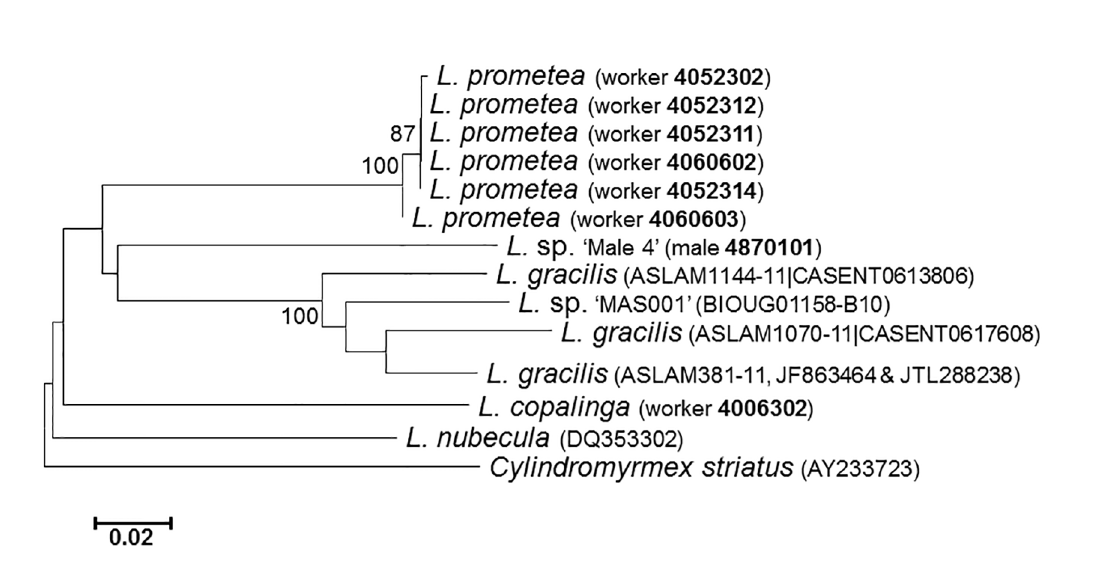
Fig. 11. Neighbour-joining tree showing p-distances among DNA sequences of the mitochondrial COI barcode fragment obtained for all specimens of Leptanilloides Mann, 1823 sequenced here and available in GenBank and BOLD. The tree was rooted with a COI sequence of Cylindromyrmex striatus Mayr, 1870 (GenBank accession number AY233723). Labels provide species identifications and field IDs (in bold) or GenBank or BOLD numbers. Values at nodes indicate bootstrap support only if it was above